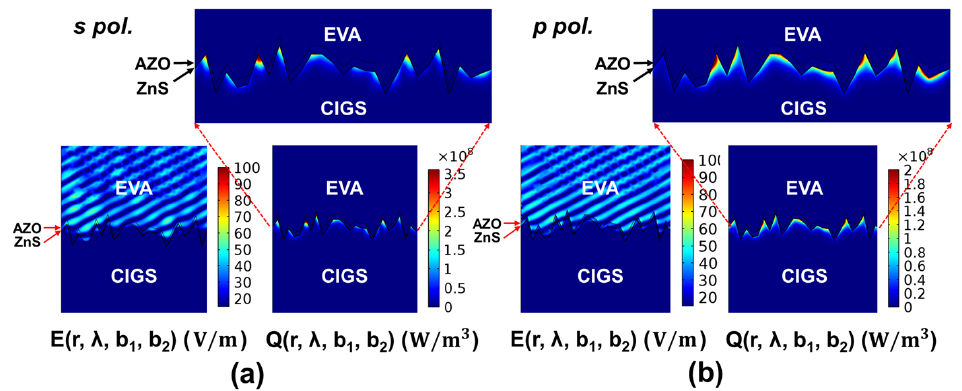
Figure 7. Spectral 2D coherent calculation results of the optical absorption in the surface-textured CIGS solar cell at the wavelength of 400 nm when the equispaced phase thicknesses in the phase-shift layers are zero ( b 1 = b 2 = 0). The RMS surface roughness is set to be σ RMS = 100 nm. The 400 nm input plane wave with the surface power density of 5.57 W/m 2 has the incidence angle of 45 ° for both ( a ) s and ( b ) polarizations. To clarify the spectral optical absorption profile near the ZnS/CIGS interface, all the calculation results are shown near the ZnS/CIGS interface.